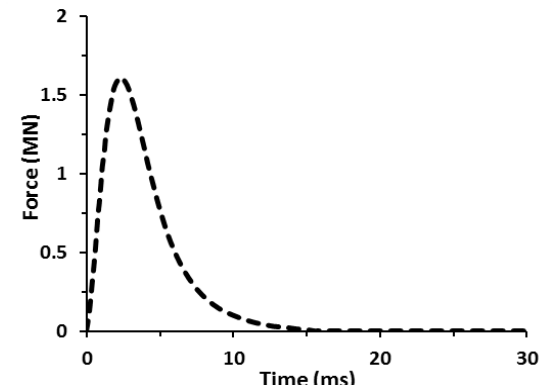
Fig. 3. Force-time history of hammer impact used in